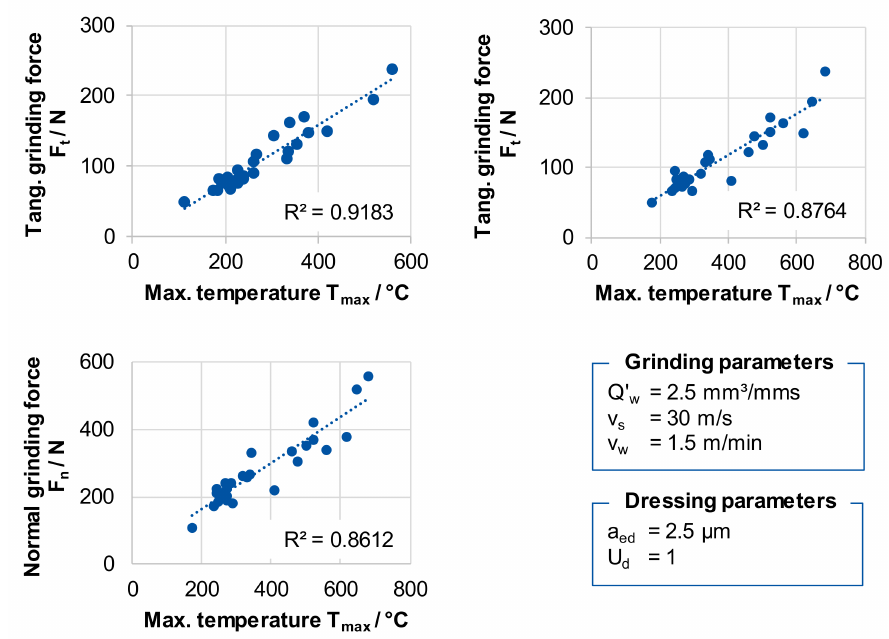
Figure 4. Correlation between the process force and the process